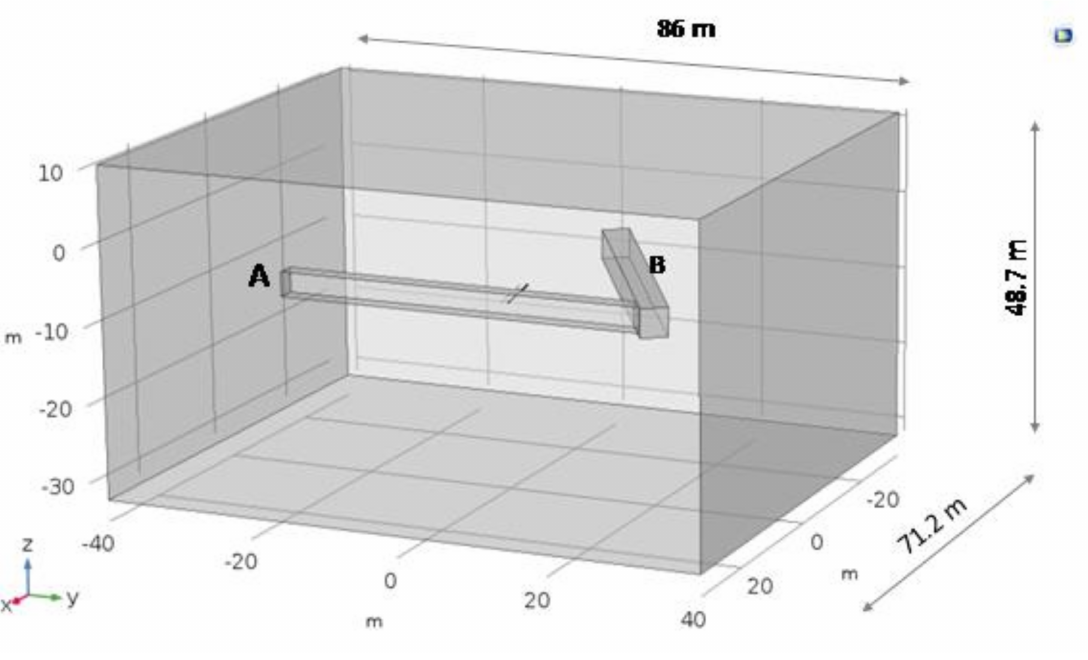
Figure 5. The geometry of the 3D numerical model of the in situ